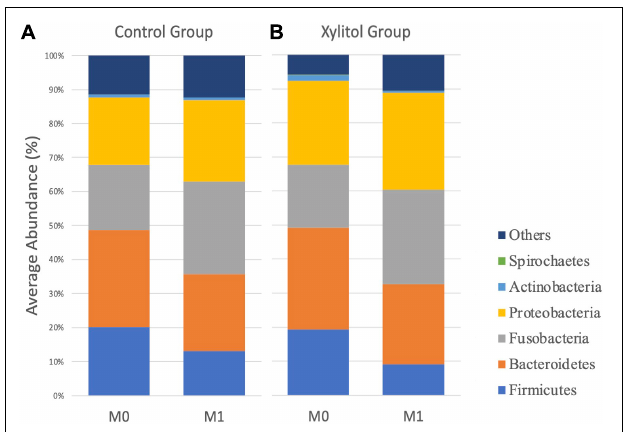
FIGURE 2 | The average profile of OTUs of oral dental plaque at the phylum level at M0 and M1 from the (A) control group and (B) xylitol gum group.